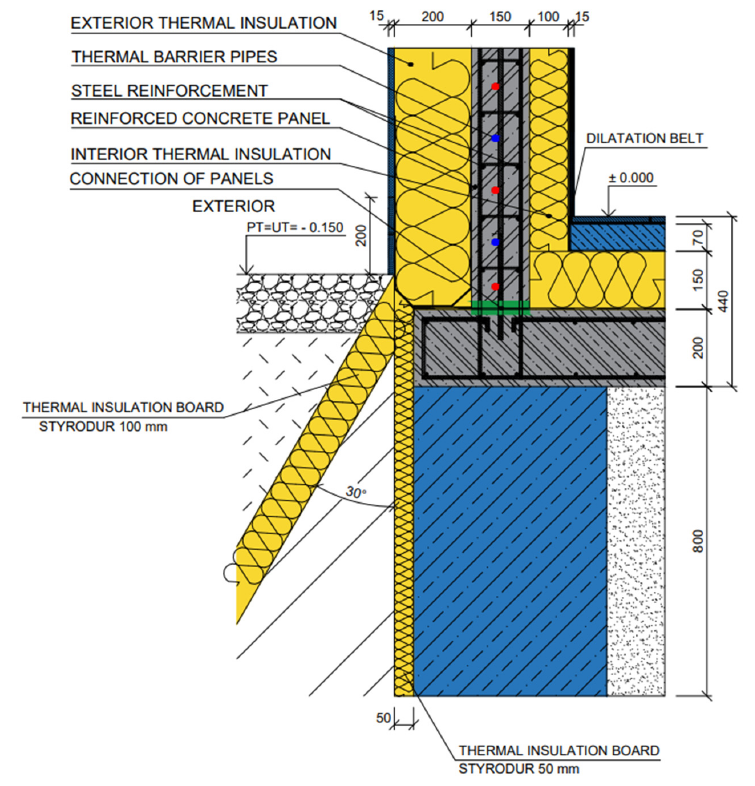
Figure 15. “Detail E”, the joint of the perimeter panel with the base plate. The colored points (red and blue) in the picture are thermal barrier